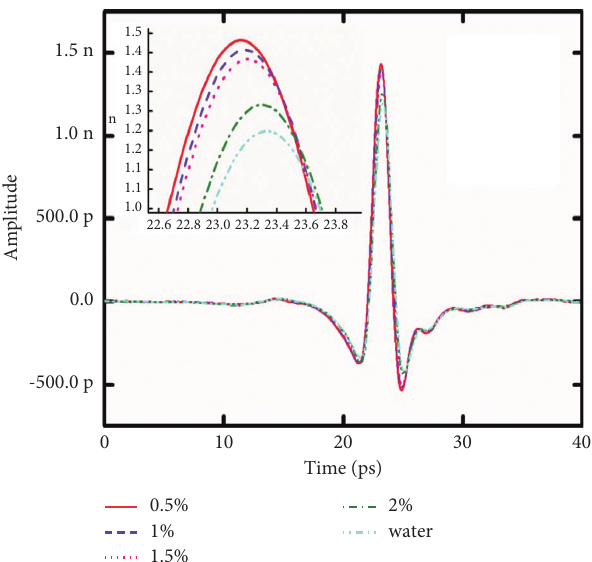
Figure 4: THz time-domain spectra of the CMC-Na colloid at different concentrations.